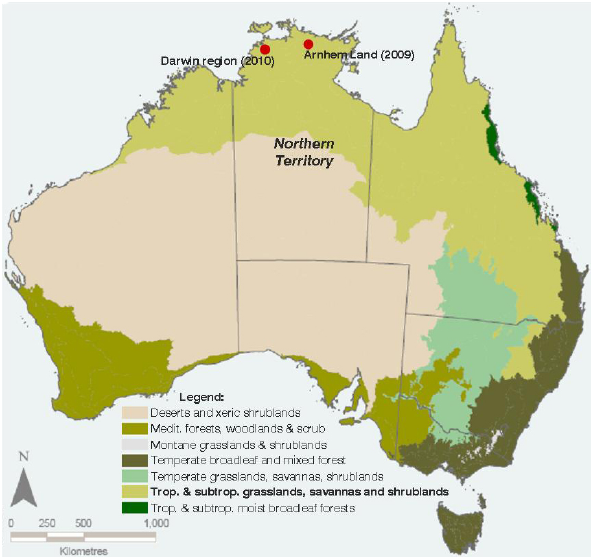
Figure 3. Map of Australia, showing the two field campaign lo- cations. Both the Arnhem Land and Darwin Region campaigns are situated in the “tropical and subtropical grasslands, savannas and shrublands” terrestrial ecoregion (adapted from Parks Australia, 2010).